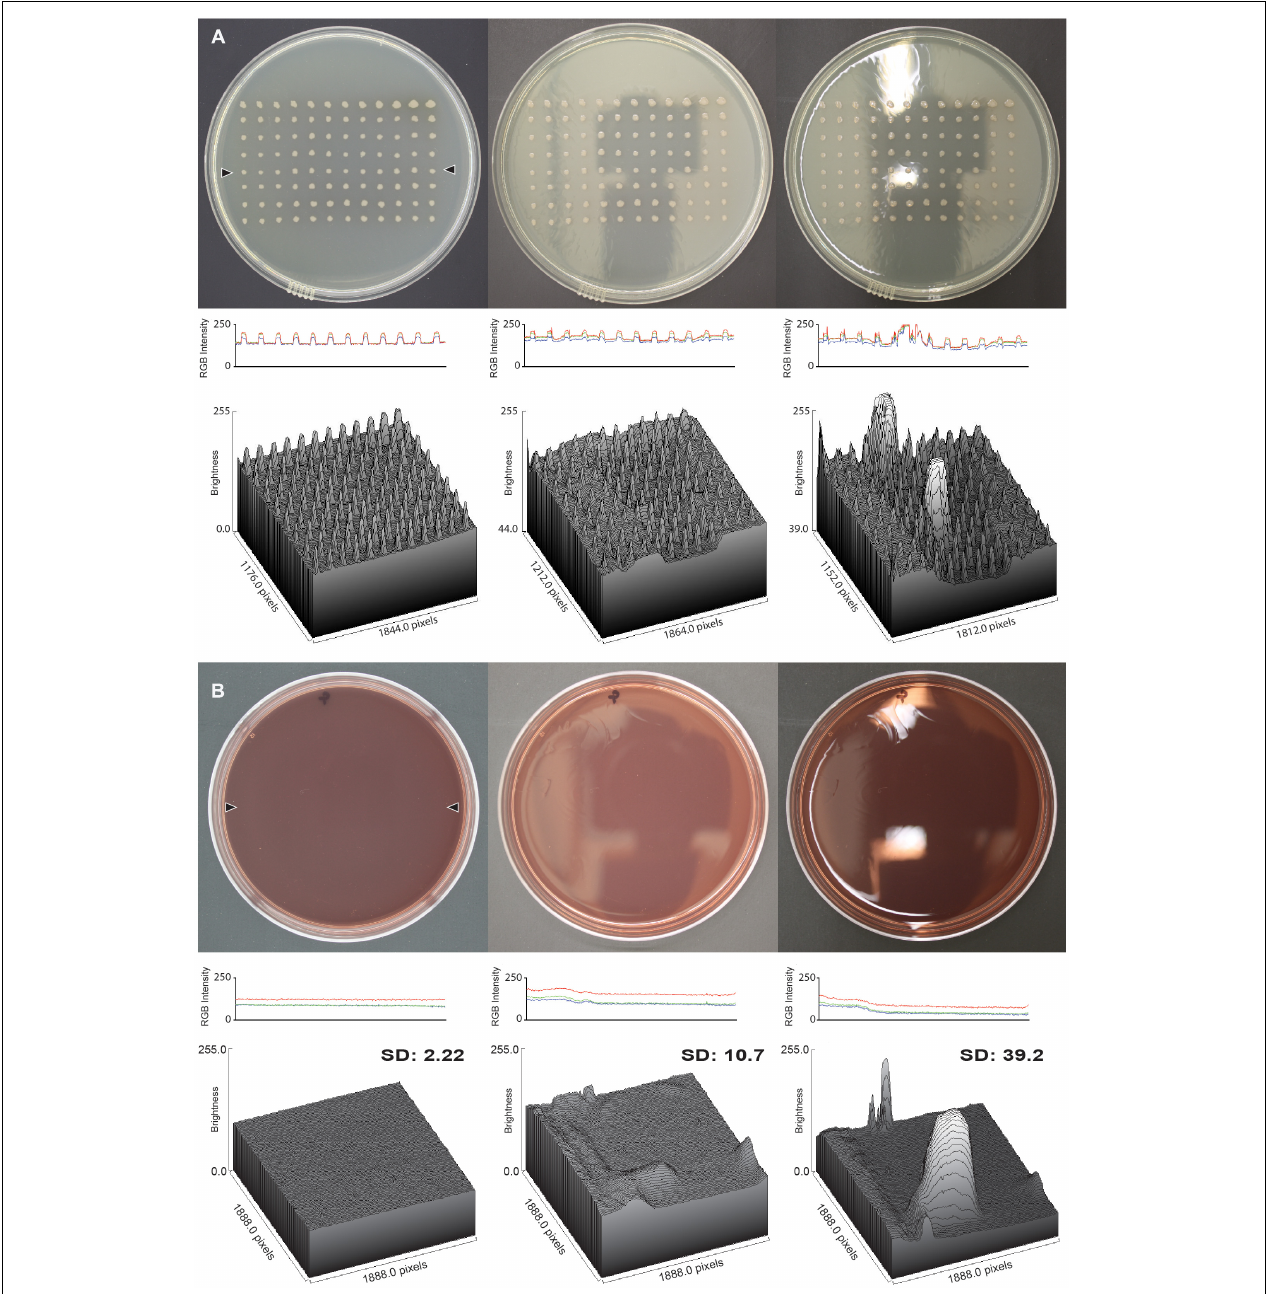
FIGURE 2 | Glare reduction in images captured with the imaging box. (A) Analysis of an LB replica plate with colonies of P. aeruginosa , and (B) an empty MacConkey agar plate, in both cases imaged in the imaging box (left column), without the imaging box but in an optimized location (center column), and without the imaging box on the lab bench (right column). The middle row shows the RGB profile plot of the images in the top row. The plot measures the RGB intensity of a line of pixels drawn across the plates between the locations marked by the two black triangles in the image captured with the imaging box. The line for the RGB profile plot was drawn in the same spot on all three plates, and the analysis was carried out in ImageJ. The bottom row shows the three-dimensional surface plot of pixel brightness of a grayscale image from a rectangular area that captured as much surface area on the plate as possible without including the edge of the plate. The standard deviation of the brightness is shown for each surface